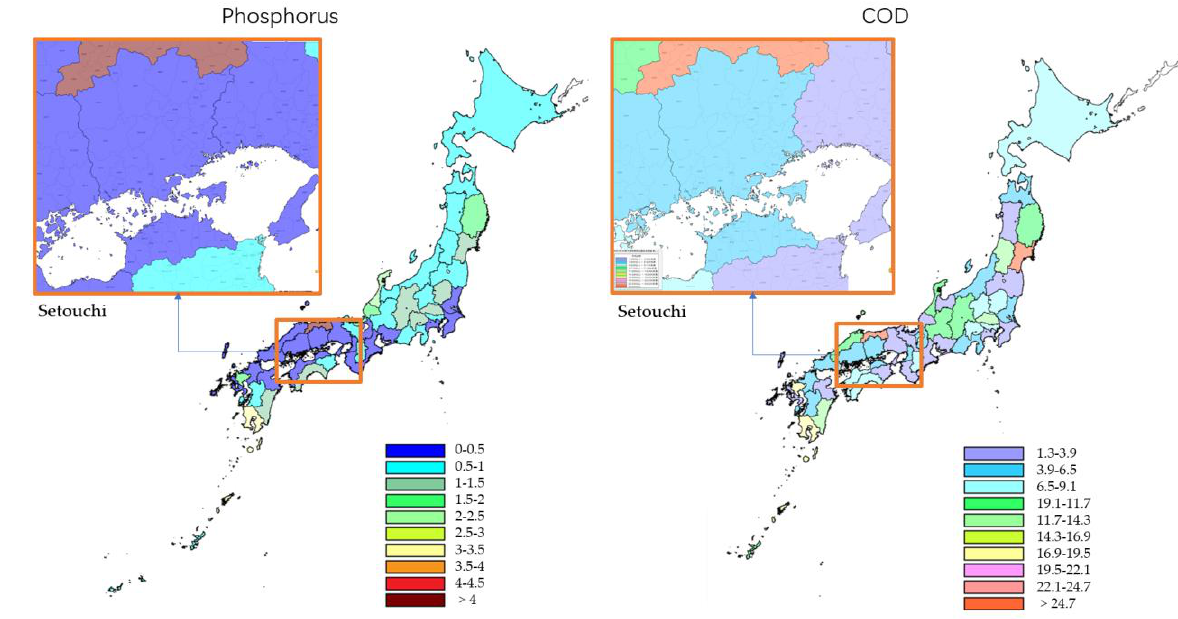
Figure 2. Pollution load of living environment items by cities in Japan